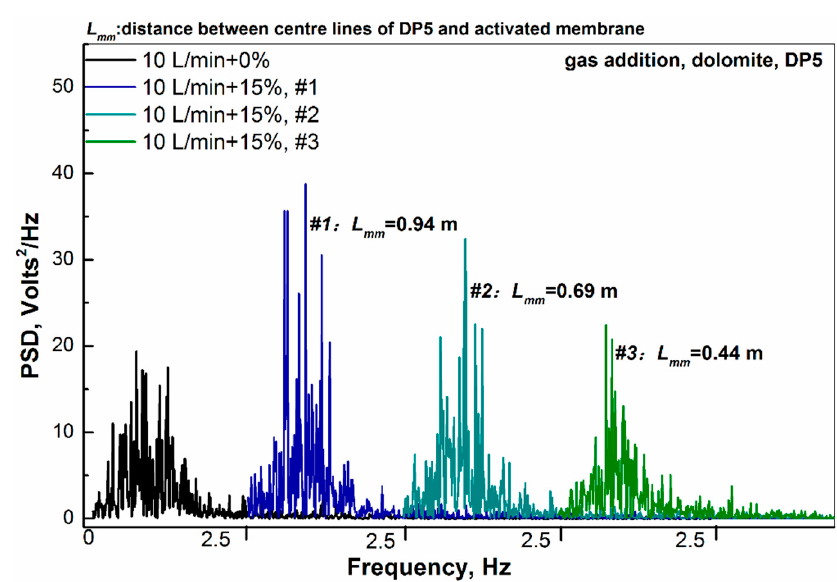
Figure 10. Effects of the gas addition location on the power spectra of the differential pressure measured at DP5. The other operational conditions: T = 550 ◦ C, P = 0.1 MPa, H in i = 1.28 m, U = 0.09 m/s, addition rate = 1.5 L/min, calcined dolomite.